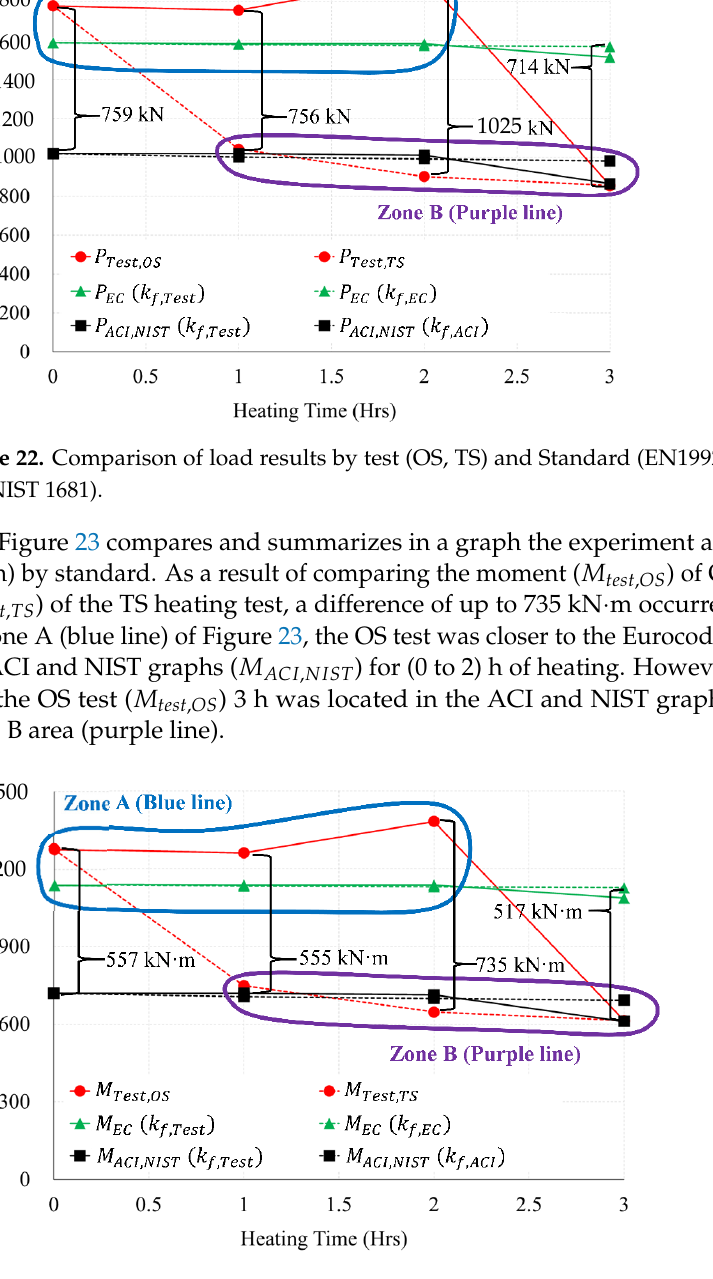
Figure 23. Comparison of moment results by test (OS, TS) and Standard (EN1992-1-2, ACI 216.1M-14 and NIST 1681).